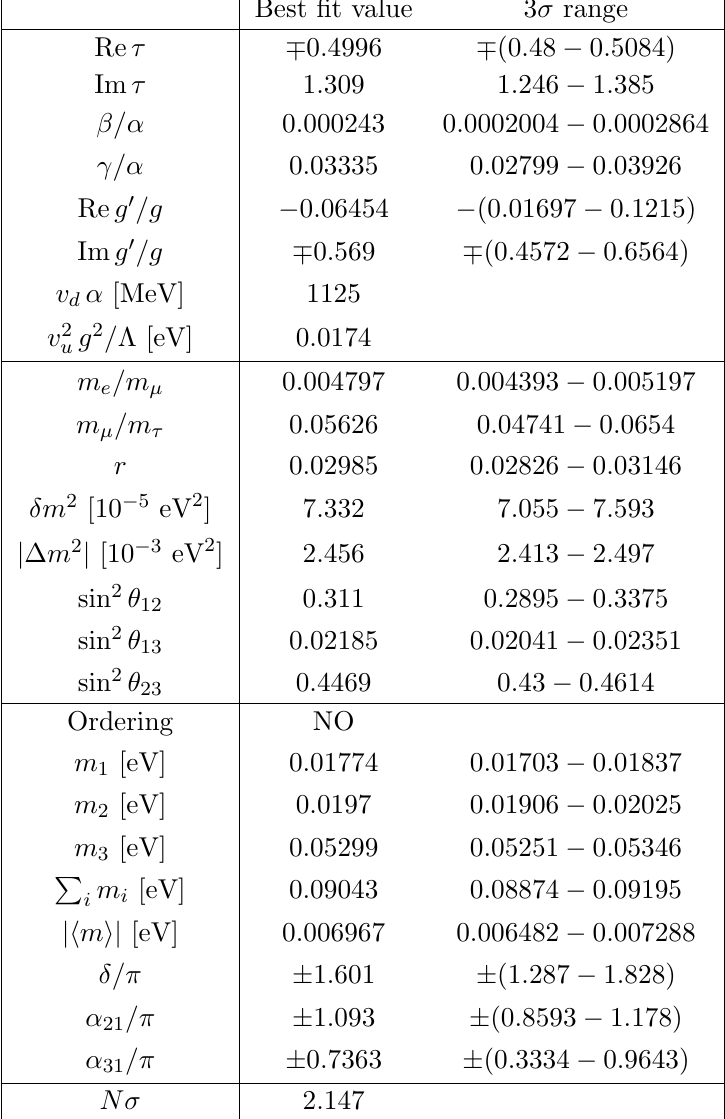
Table 5e. Best (cid:12)t values along with 3 (cid:27) ranges of the parameters and observables in cases E and E (cid:3) , which refer to ( k (cid:3) ; k g ) = (0 ; 2) and to a certain region in the (cid:28) plane (see (cid:12)gure